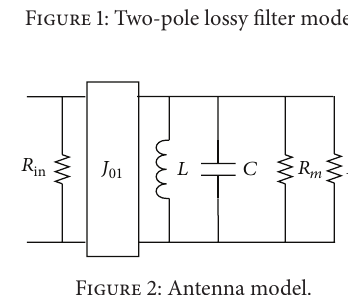
Figure 2: Antenna model.